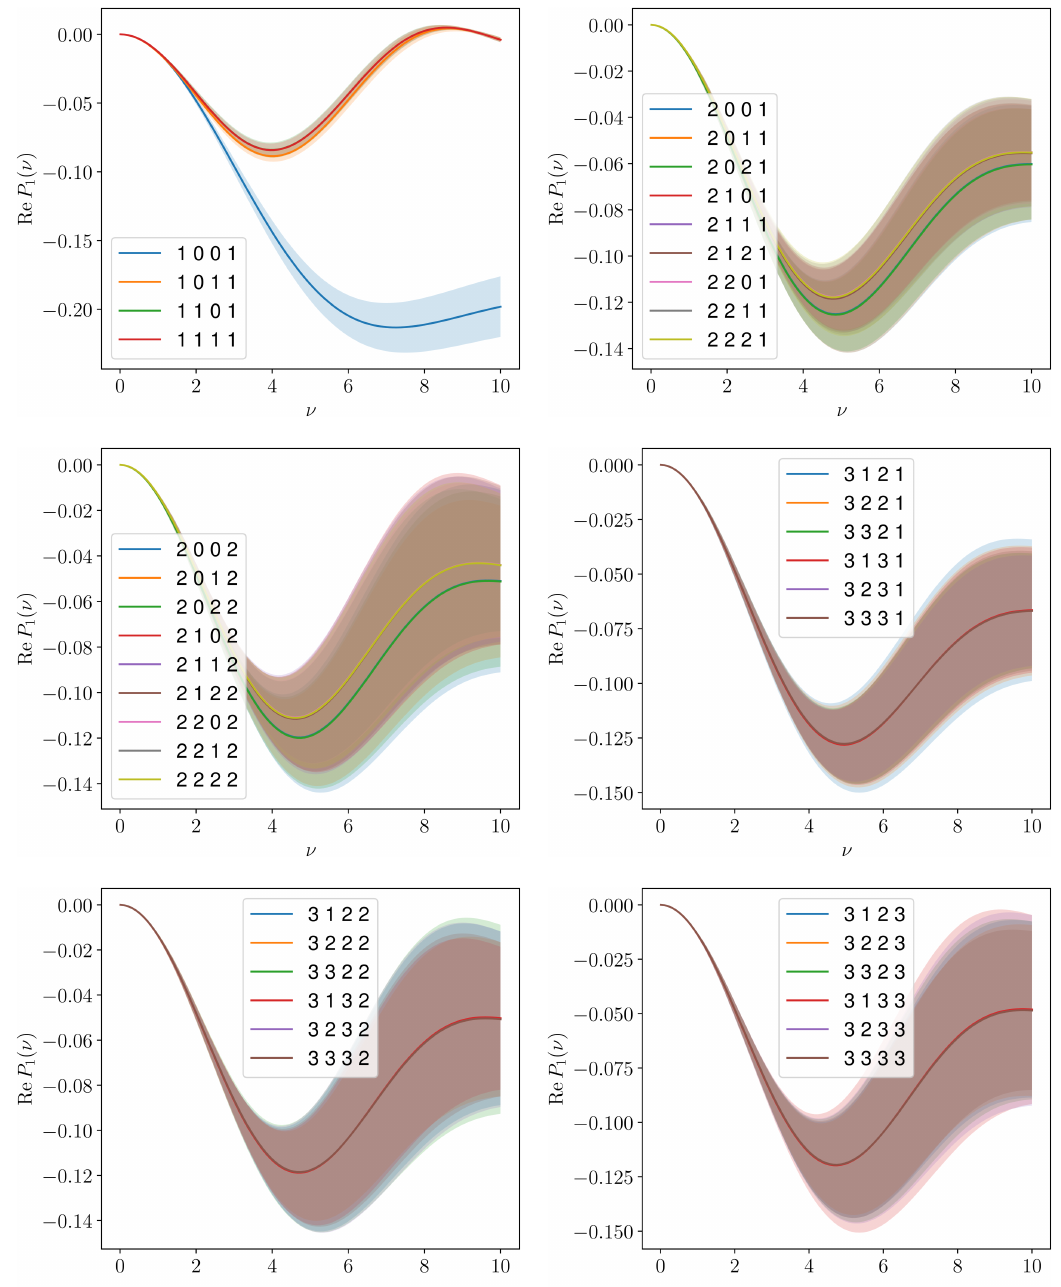
Figure 28 . The higher twist term, B 1 , results from fitting the real component to the models. The numbers in the legend correspond to ( N ± , N